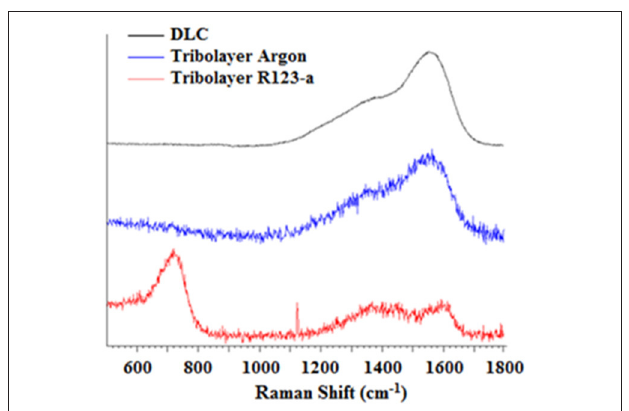
FIGURE 6 | Comparison of the Raman spectra of tribolayers obtained in atmospheres of argon, R134-a and the original DLC (Barbosa et al., 2015).